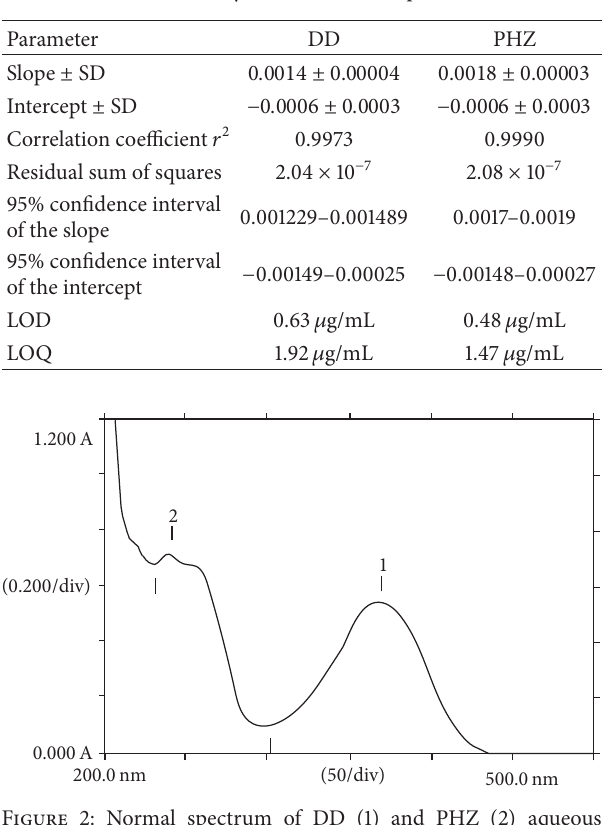
Table 1: Linearity data of the developed method.